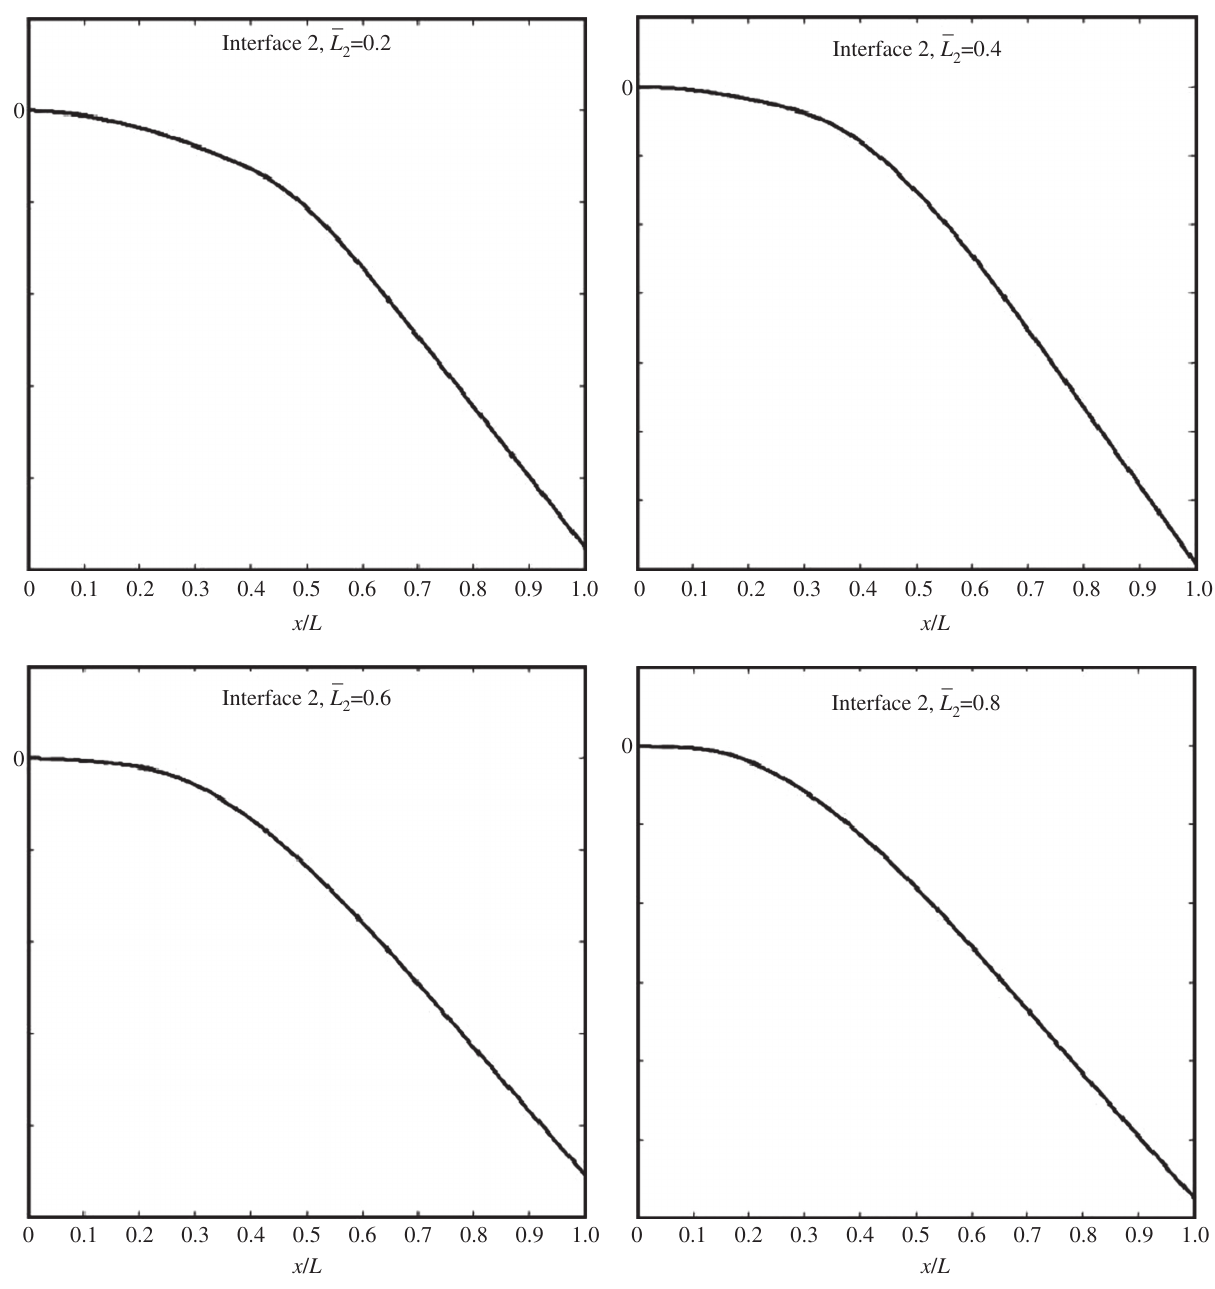
Figure 12 First mode shape of a LCB with delamination located at interface 2 related to four different lengths of